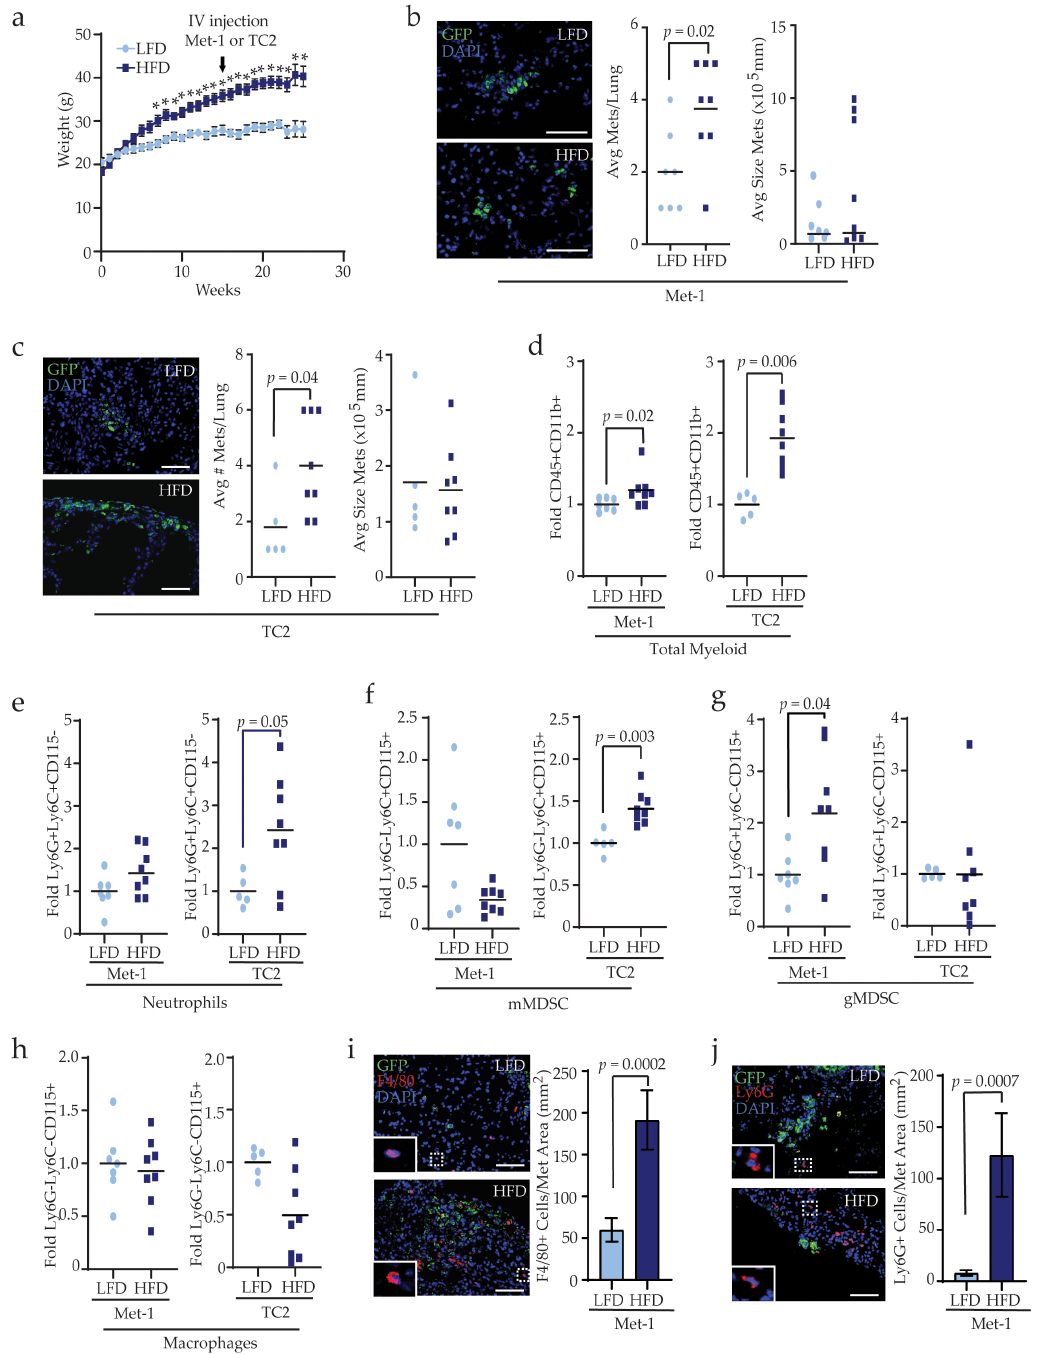
Figure 2. Obesity enhances myeloid lineage cells during metastasis. ( a ) Weight gain of mice fed LFD (n = 12 mice) or HFD (n = 16 mice). Arrow indicates the time point of tail vein injections of Met-1 or TC2 cells (* p < 0.05). Quantification of number and size of GFP + metastatic foci in lungs of LFD- and HFD-fed mice injected with Met-1 ( b ) n = 7 mice LFD; n = 8 mice HFD) or TC2 ( c ) n = 5 mice LFD; n = 8 mice HFD) tumor cells. Flow cytometry quantification of CD45 + CD11b + myeloid lineage cells ( d ) Ly6G + Ly6C + CD115 − neutrophils ( e ), Ly6G − Ly6C + CD115 + monocytic myeloid-derived suppressor cells (monocytic myeloid-derived suppressor cells (mMDSCs), ( f ) Ly6G + Ly6C − CD115 + granulocytic MDSC (granulocytic MDSCs (gMDSCs), and ( g ) Ly6G − Ly6C − CD115 + macrophages ( h ) in lungs from mice injected with either Met-1 or TC2 tumor cells. Results were normalized to CD45 + CD11b + cells and expressed as fold changes compared to controls. ( i ) Quantification of F4/80 + macrophages surrounding lung metastases (n = 5 mice/group). ( j ) Quantification of Ly6G + neutrophils and gMDSC surrounding lung metastases. Magnification bars = 50 µ